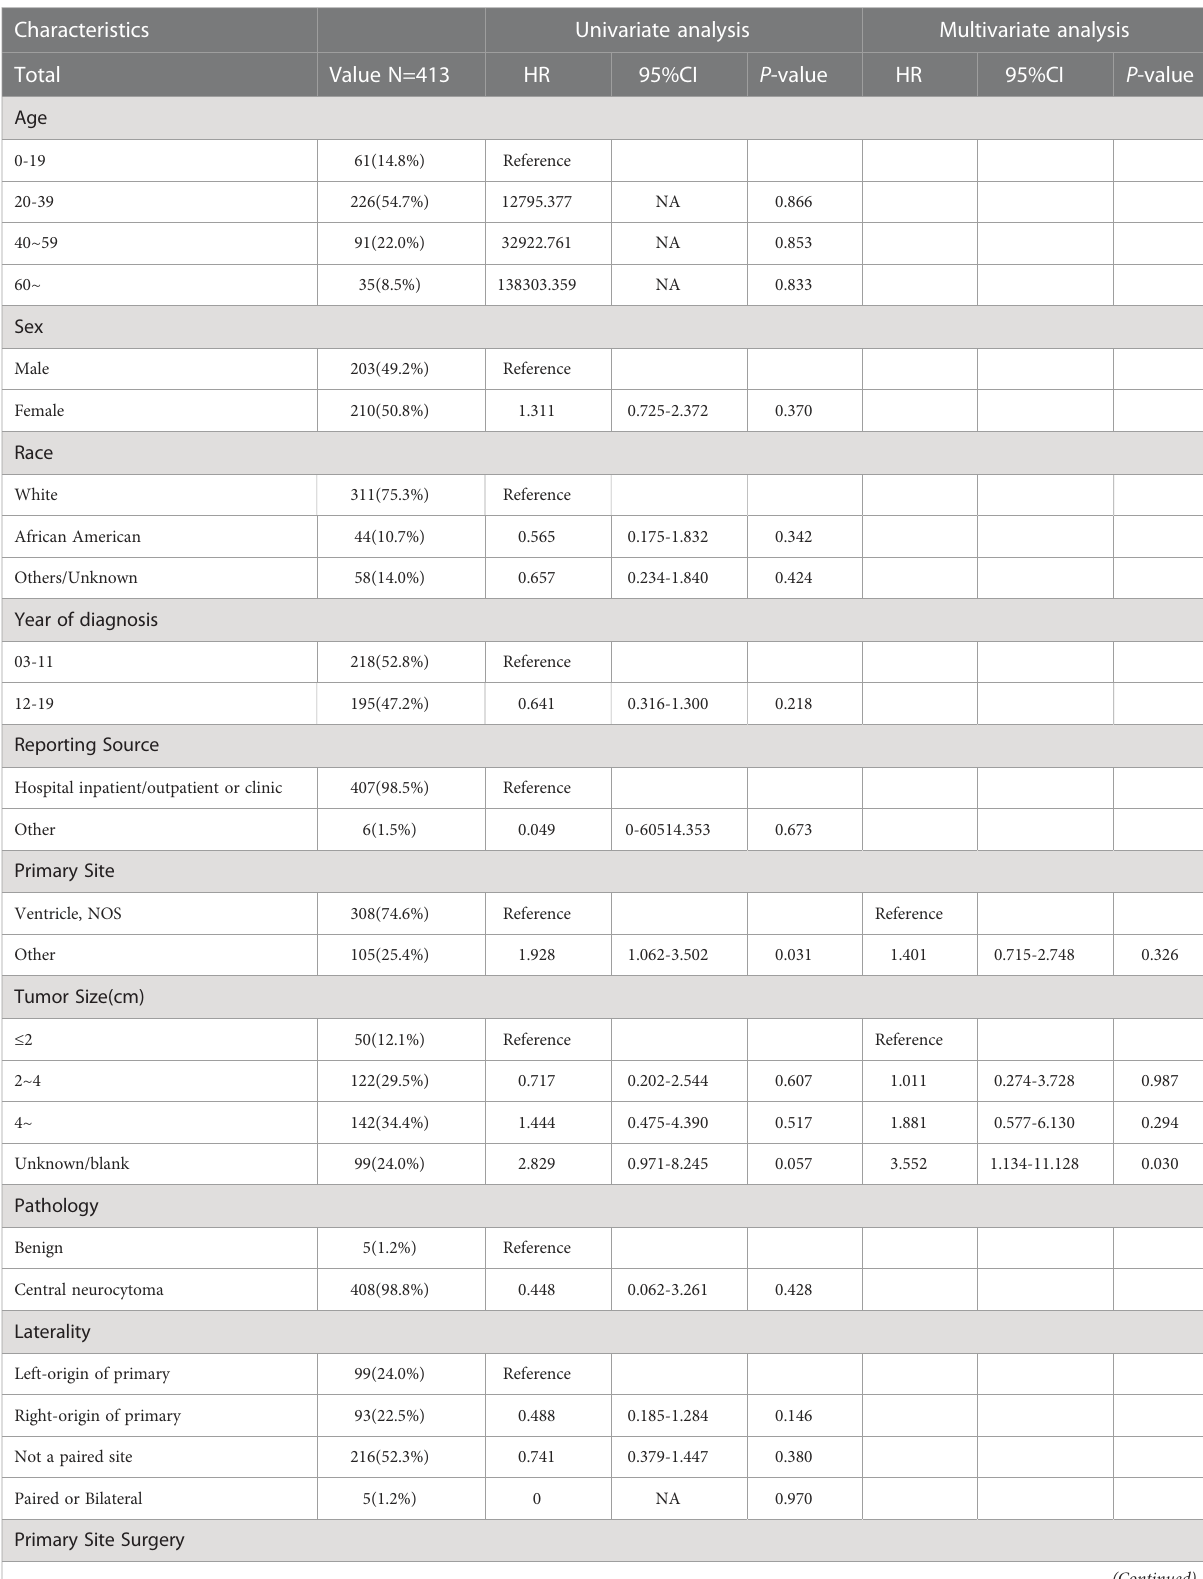
TABLE 1 Details of patients with central